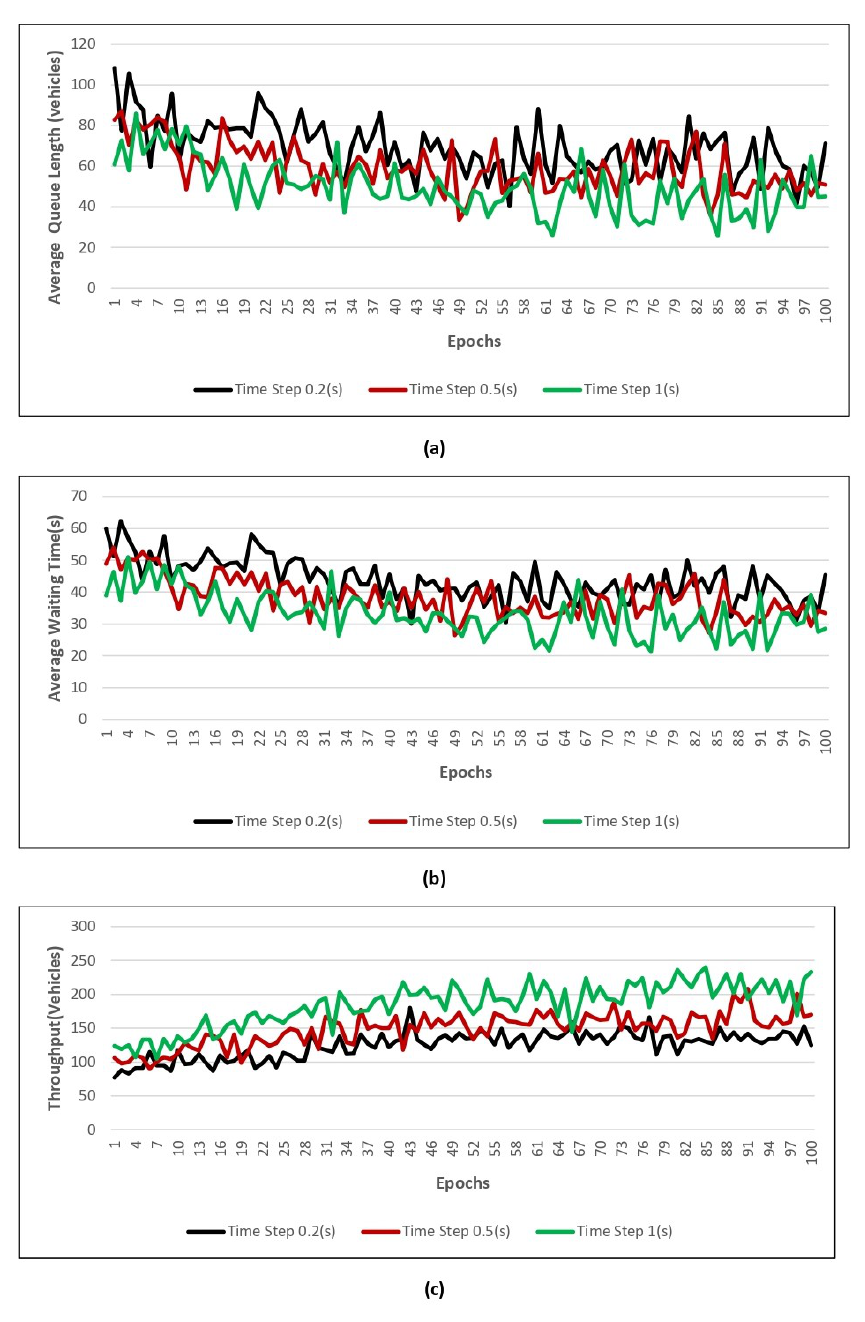
Figure 13. Performance results while training with three action time steps using 100 epochs. ( a ) AQL. ( b ) AWT. ( c )